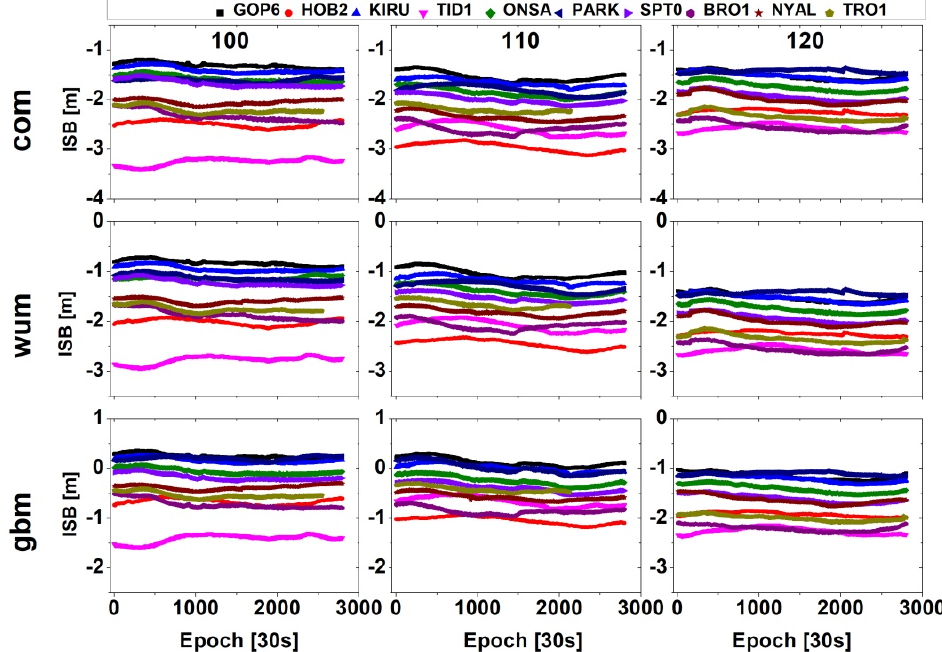
Figure 2. Daily variations in ISB between BDS-3 and BDS-2 for 10 stations. The panels from top to bottom show the results of the com, wum, and gbm precise products.